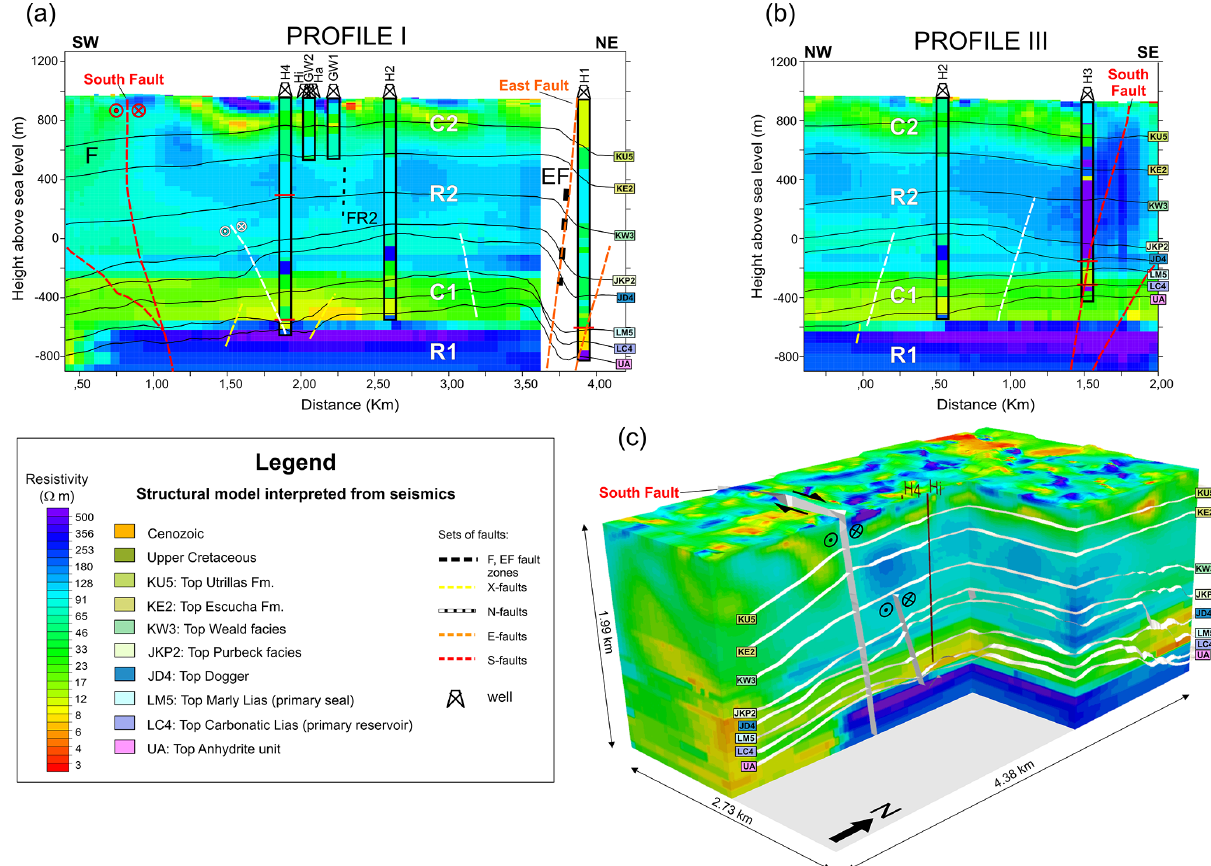
Figure 5. Joint structural interpretation. (a) Profile I of the 3-D MT model and superimposed, α profile of the 3-D seismic model. (b) Section III of the MT model and superimposed, β profile of the seismic model. (c) 3-D view of the MT model and the seismic model (structural model). Geoelectrical model: the main resistive layers (R1, C1, R2, and C2) and the F and EF fault regions are indicated. Possible FR2 fracture regions are also specified. The 1-D resistivity models derived in Ogaya et al. (2014) for each well appear superimposed. Seismic model: the top of the main units (black lines) and the main fault sets (X-fault, N-faults, E-faults, and S-faults) are indicated.